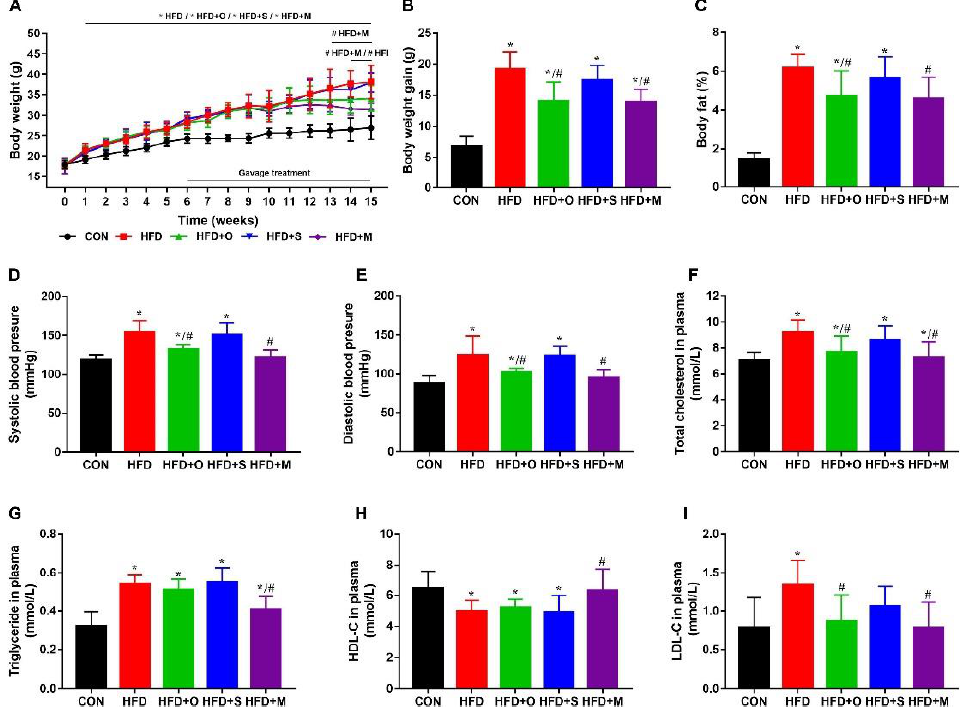
Figure 5. The effect of Octa monomer and the microcapsule on the HFD − induced obesity model in C57BL/6 mice. (CON: control group; HFD: obesity model group; HFD+O: HFD + Octa group; HFD+S: HFD + shell material group; HFD+M: HFD + microcapsule group) ( A ) The body weight growth of mice. The curves show the body weight growth during the experimental period. ( B ) The body weight gain after the 15 − week experimental period. ( C ) The body fat percentage of mice. ( D − E ) The blood pressure ( D : systolic blood pressure; E: diastolic blood pressure). ( F ) Total cholesterol in plasma. ( G ) Triglyceride in plasma. ( H ) HDL − C in plasma. ( I ) LDL − C in plasma. * p < 0.05, when compared with the CON group. # p < 0.05, when compared with the HFD